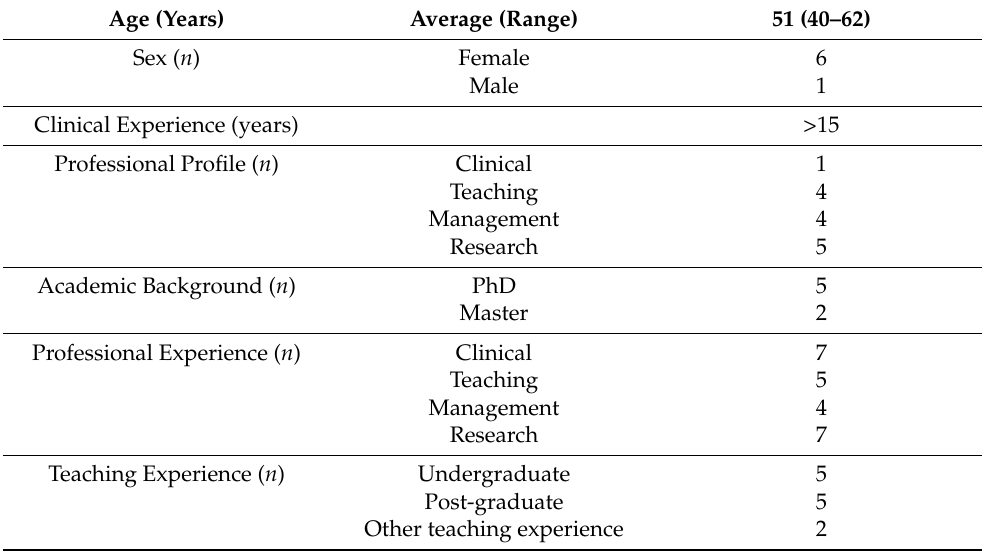
Table 2. Characteristics of expert